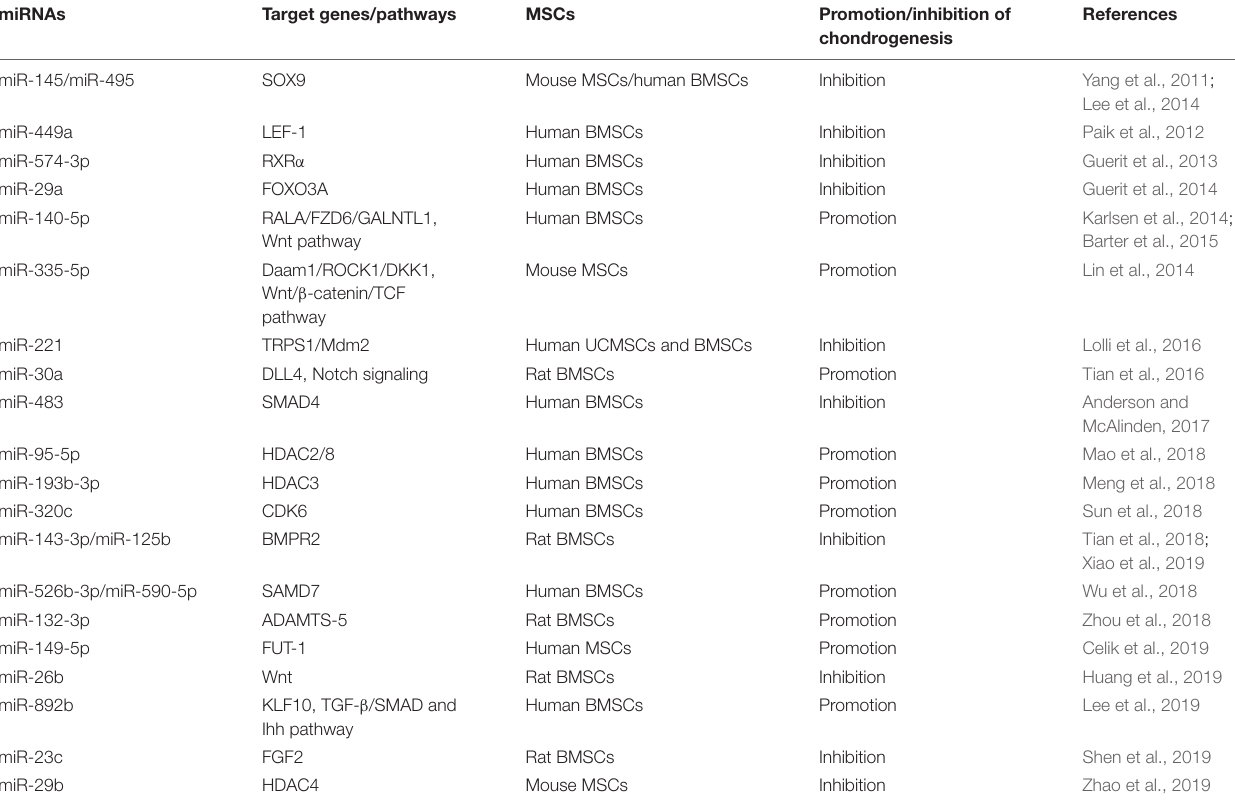
TABLE 4 | MicroRNAs involved in chondrogenesis of MSCs.